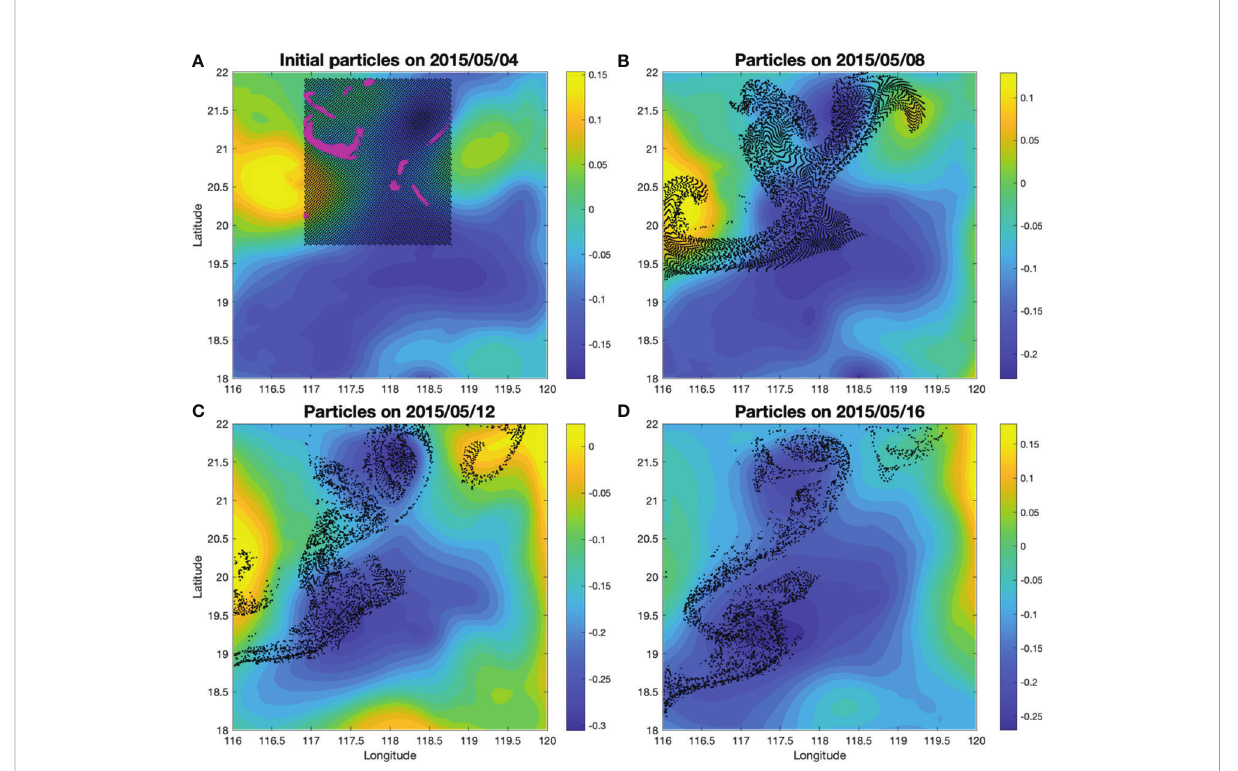
FIGURE 5 Lagrangian particle releasing results on 04 May (A) , 08 May (B) , 12 May (C) and 16 May 2015 (D) . The particles were released at the surface of a depth of 50 m. The black dots show the particle locations on different days. The shadings are SLA (units: m). The magenta circles in (A) are the particles being brought into the mixed layer 7 days after being